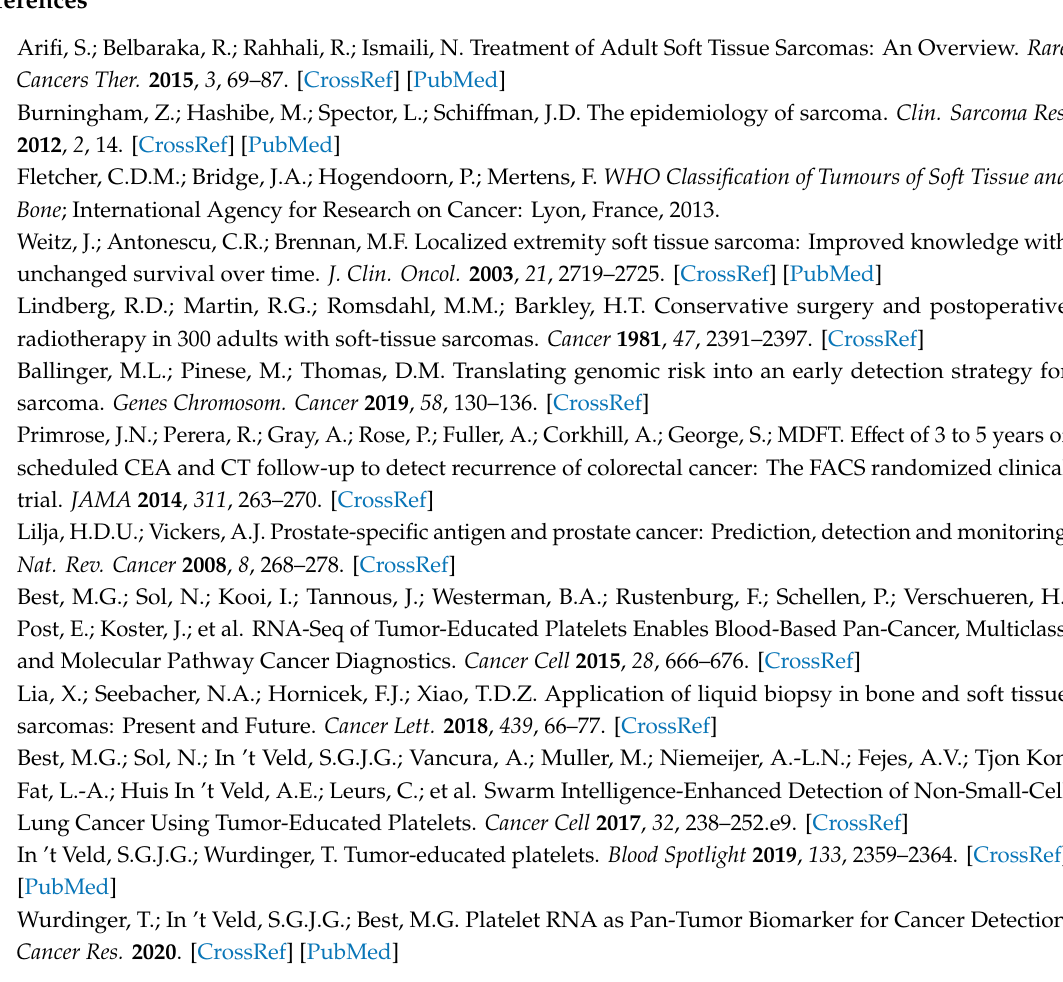
Figure S1: Inter sample correlation, Figure S2: Venn diagram, Table S1: overview of di ff erential expressed spliced junction RNAs and corresponding ANOVA results, Table S2 Swarm-enhanced biomarker-panel